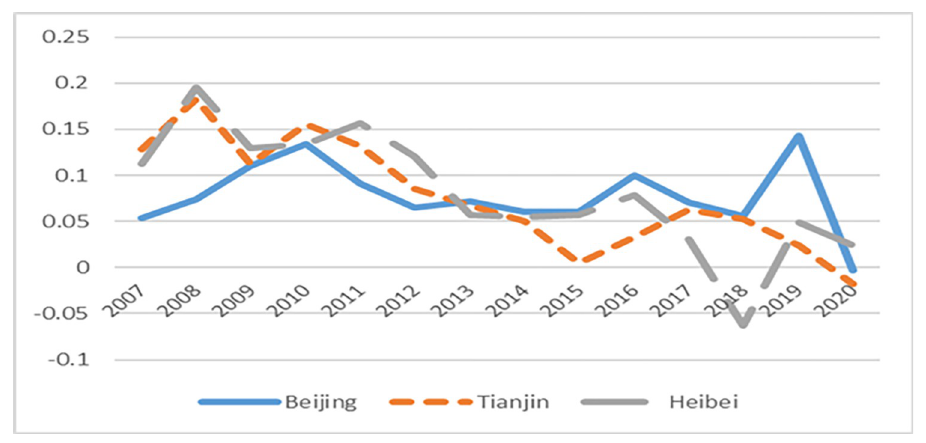
Fig 2. The trend of GDP growth rate in Beijing, Tianjin and Hebei.